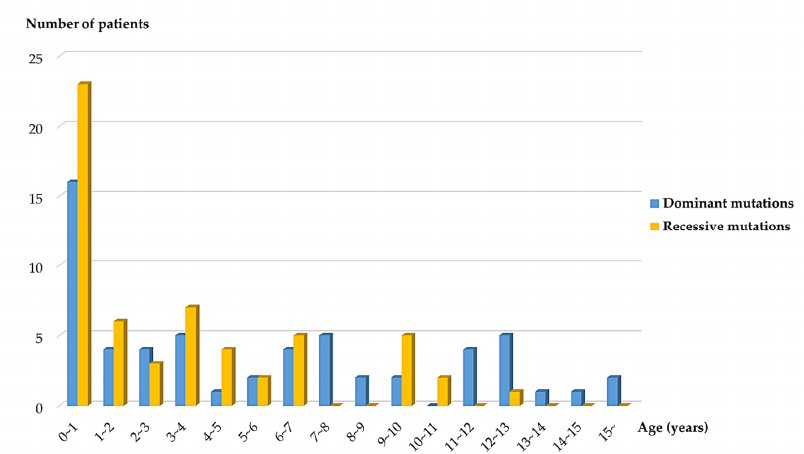
Figure 2. Distribution of dominant and recessive mutations by onset age.